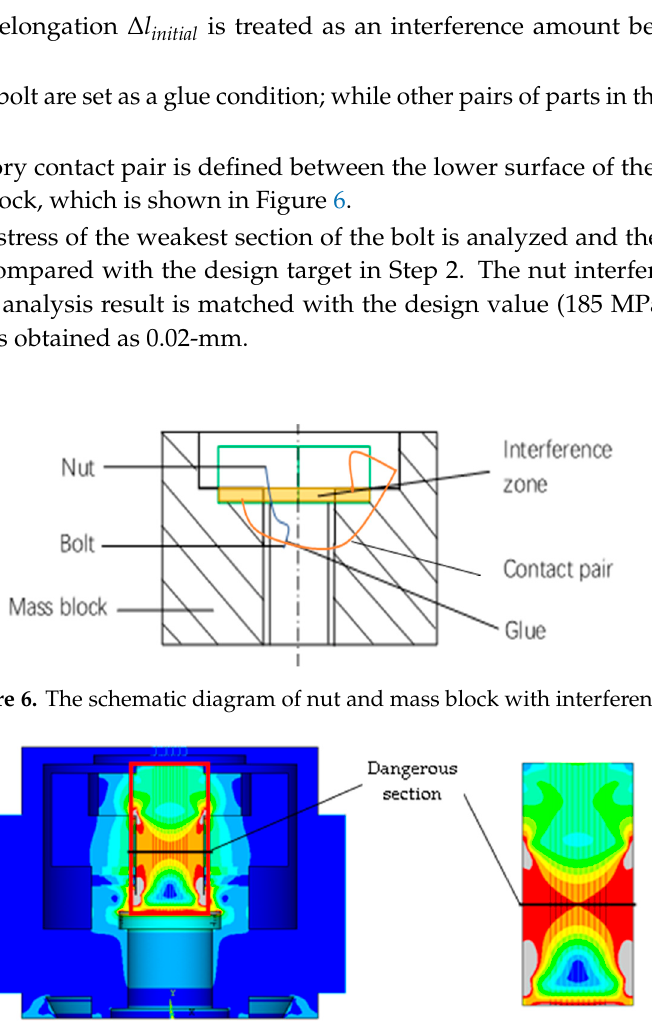
Table 2. Material properties of parts in sensing system.